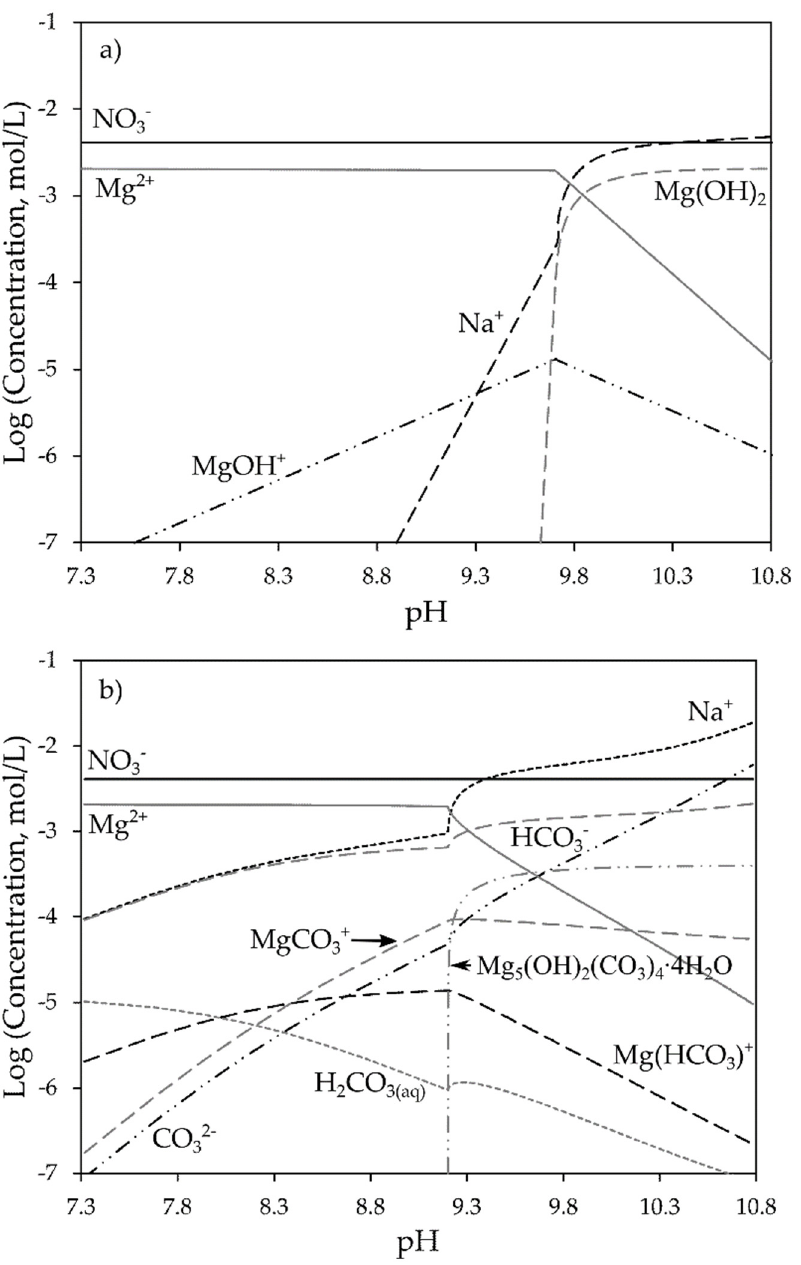
Figure 5. Species distribution diagrams of the ( a ) Mg-H 2 O and ( b ) Mg-CO 3 -H 2 O systems for 50 mg/L of Mg at 25 °C. The latter diagram stands for the cumulative addition of 2 g/L of Na 2 CO 3 to 1 L of solution. Hydromagnesite starts to precipitate when 0.05 g/L of soda ash has been added.